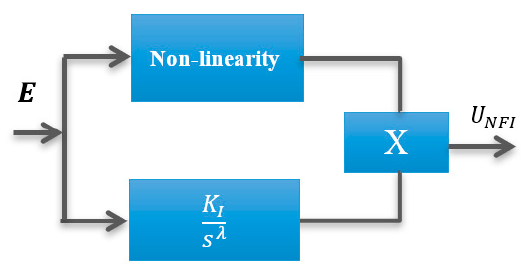
Figure 8. Non-linear fractional order integrator.